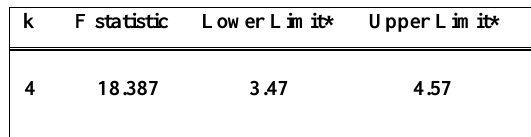
Table 1: Unit Root Test Results for Level Values of the